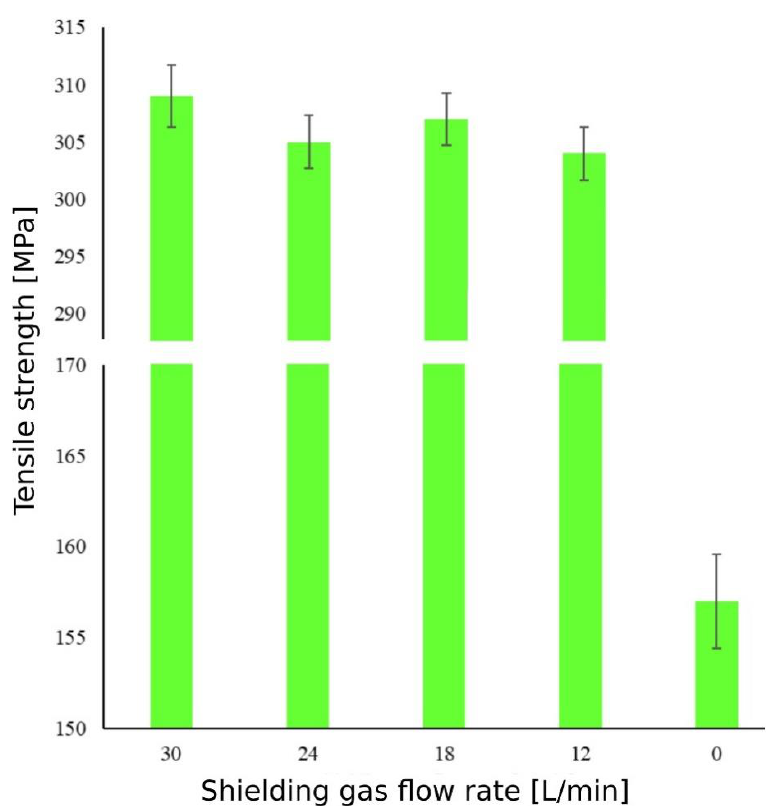
Figure 16. The effect of the shielding gas flow rate on the tensile strength. Figure 16. The e ff ect of the shielding gas flow rate on the tensile strength.